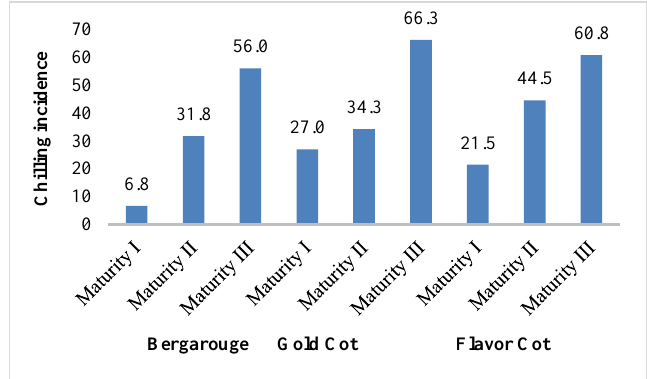
Figure 7. Effect of different harvest times (maturity classes) on chilling injuries percentage of Bergarouge, Gold Cot, and Flavor Cot